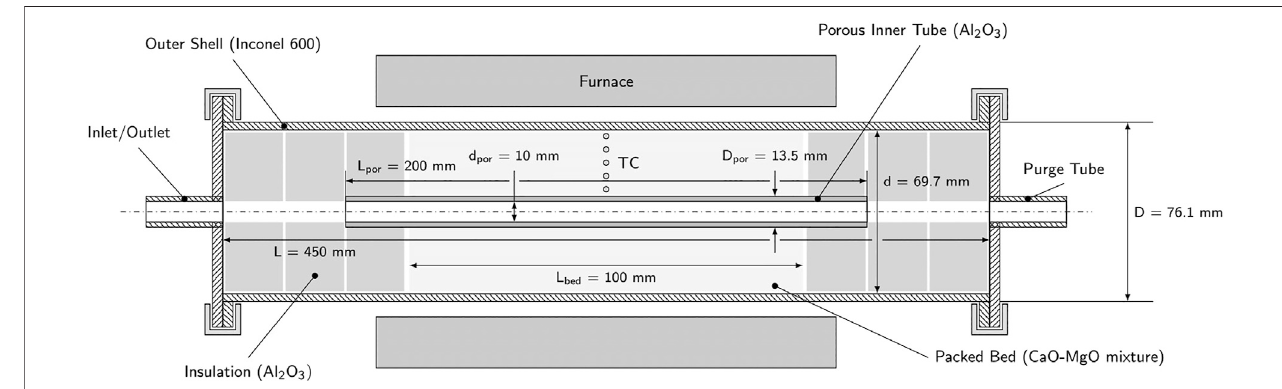
FIGURE 5 | Schematic cross-section of the experimental TCS reactor consisting of an Inconel shell, central porous gas-feeding tube, and annular packed-bed of solid reactants, enclosed by a tubular electric furnace.